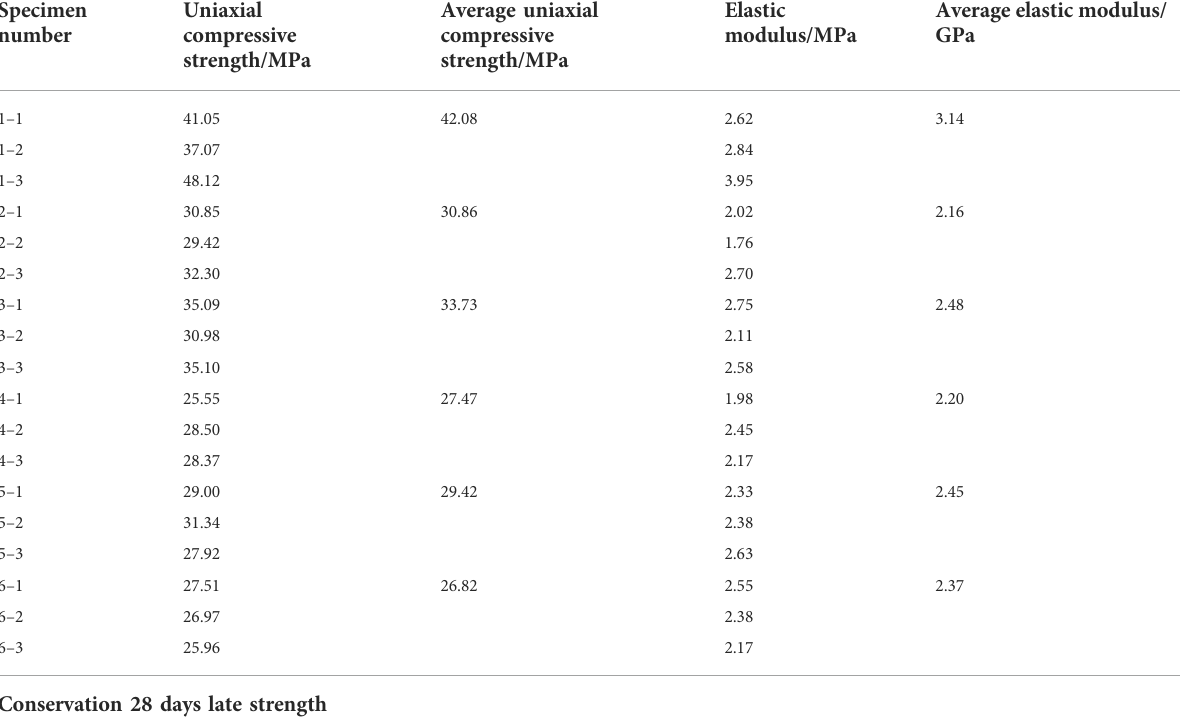
TABLE 9 Strength test results of stone